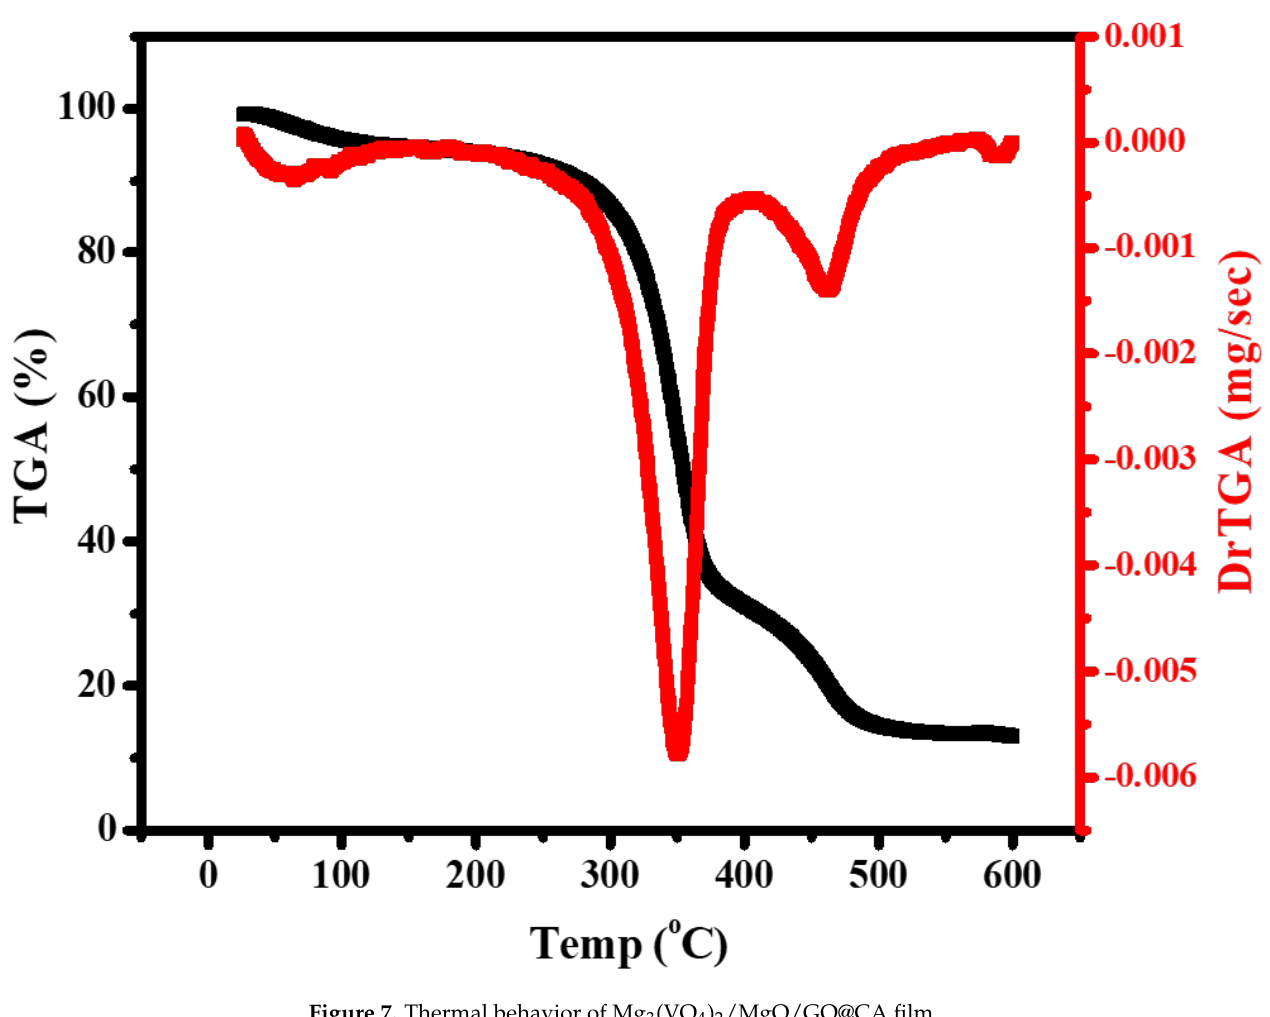
Figure 7. Thermal behavior of Mg 3 (VO 4 ) 2 /MgO/GO@CA film.